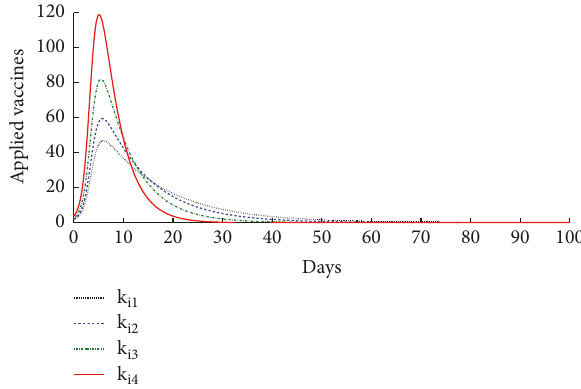
Figure 12: Evolution of the vaccines applied during the vaccination campaign for different values of 𝑘 𝑖